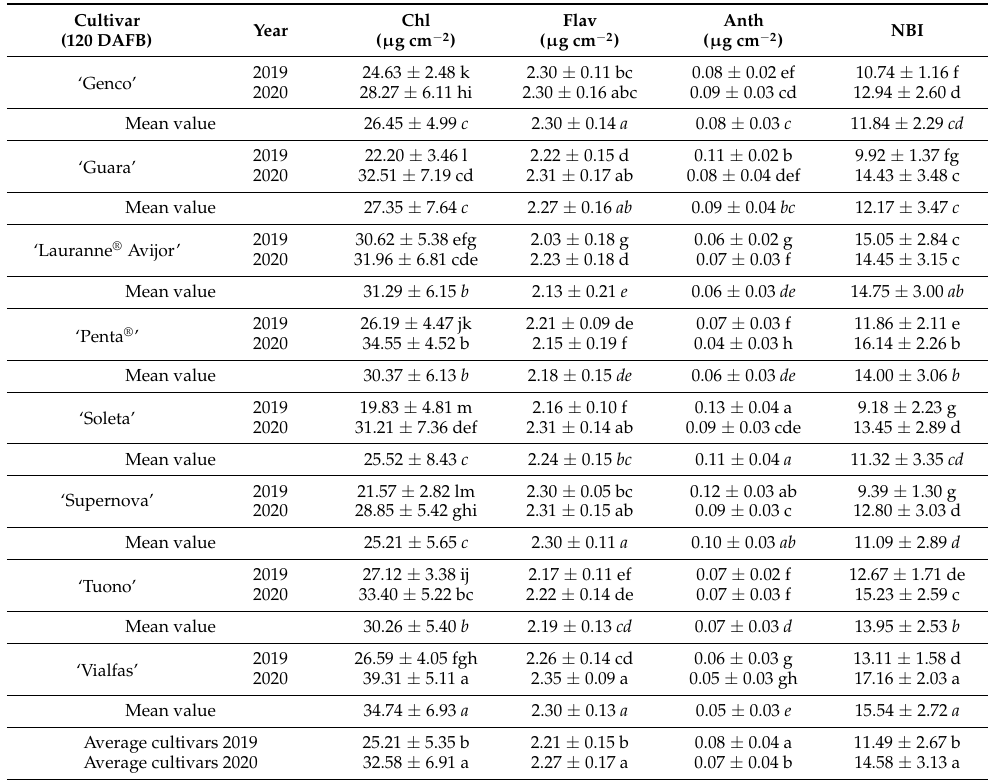
Table 9. Leaf total chlorophyll (Chl), flavonol (Flav) anthocyanin (Anth) and nitrogen balance index (NBI) in almond leaves collected at 120 DAFB over the years 2019–2020. Data are presented as mean ± standard deviation. Different lowercase letters on the columns indicate significant differences between means (Fisher’s test p < 0.05). Lowercase letters in italics describe the differences expressed as two-year mean values of the